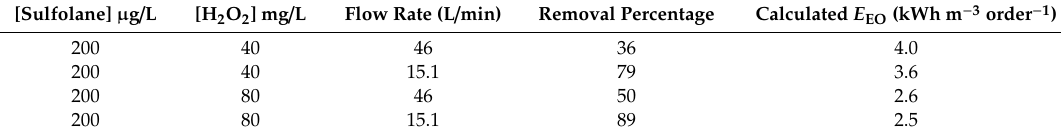
Table 3. The effect of water flow rate on sulfolane degradation in Water III in single-pass mode.